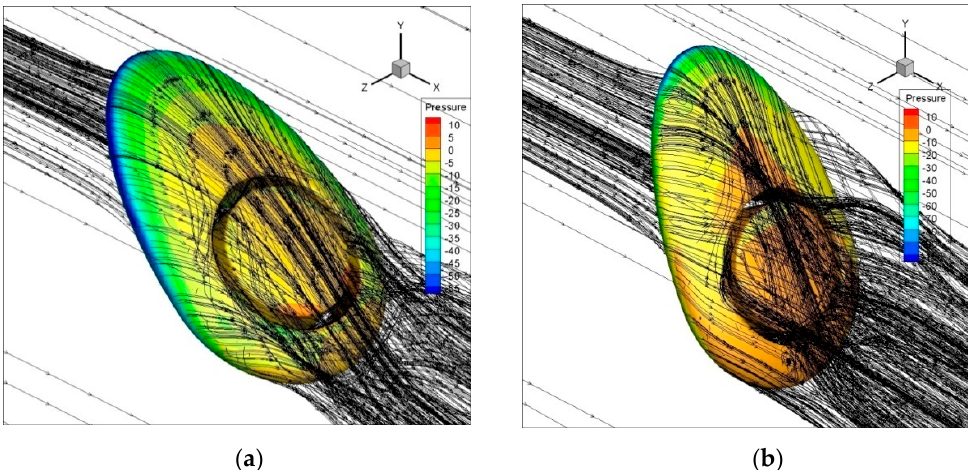
Figure 16. The flow behavior of the hybrid airship for δ = 0.0583 at ( a ) α = 40° (pre-stall region) and ( b ) α = 60° (post-stall region).